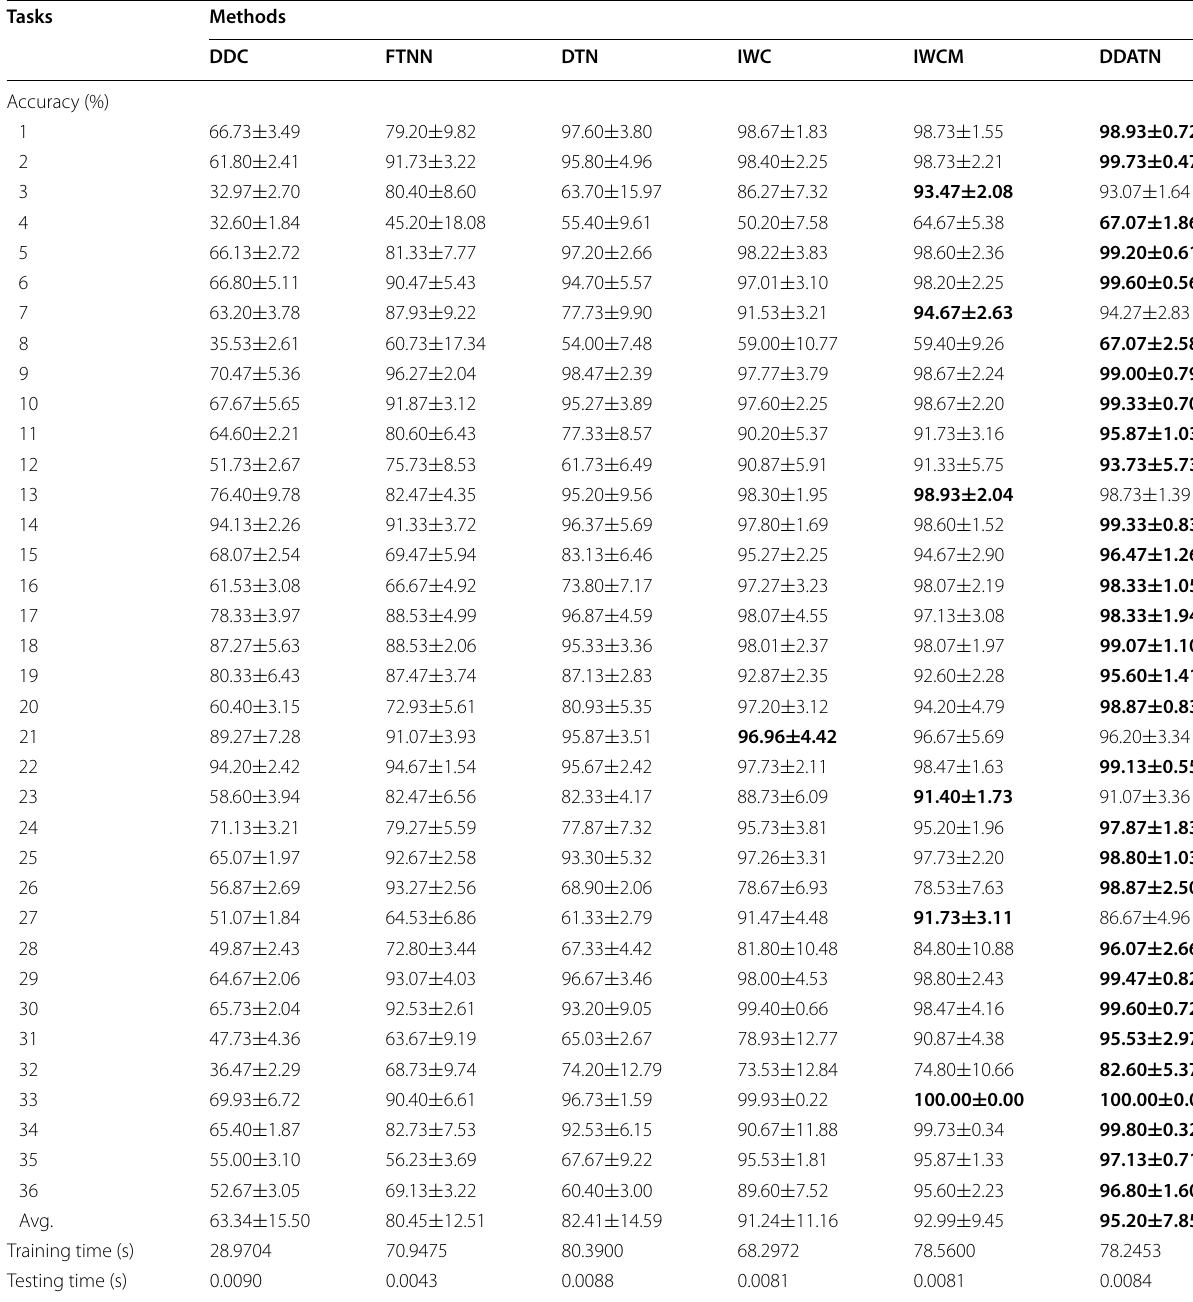
Table 5 Comparison